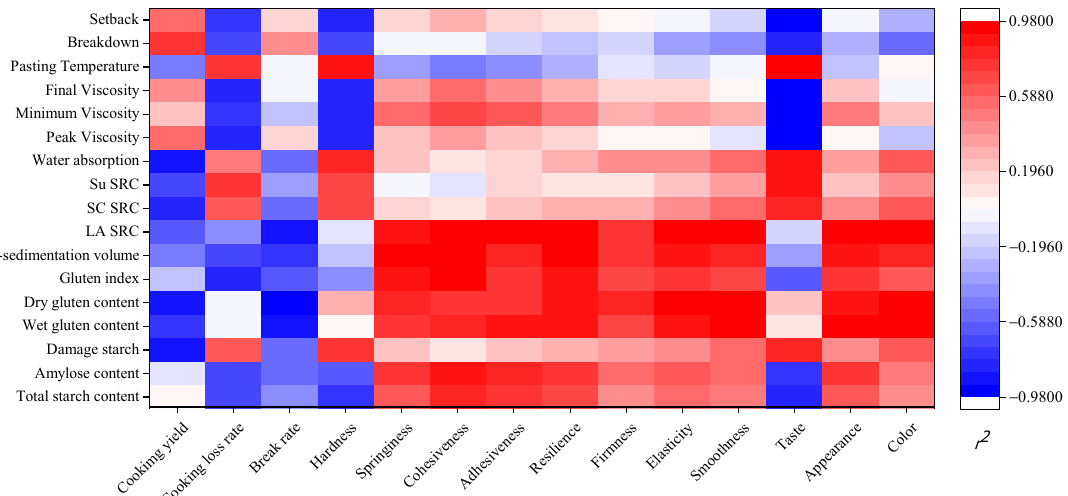
Figure 5. Heat map of correlation coefficients of the quality between the wheat flour and its cooked noodles. r 2 is the correlation coefficient. The LA SRC, SC SRC, and Su SRC represent the retention capacity of the whole-wheat flour to the 5% ( m / v ) lactic acid, 5% ( m / v ) sodium carbonate, and 50% ( m / v ) sucrose solutions, respectively.